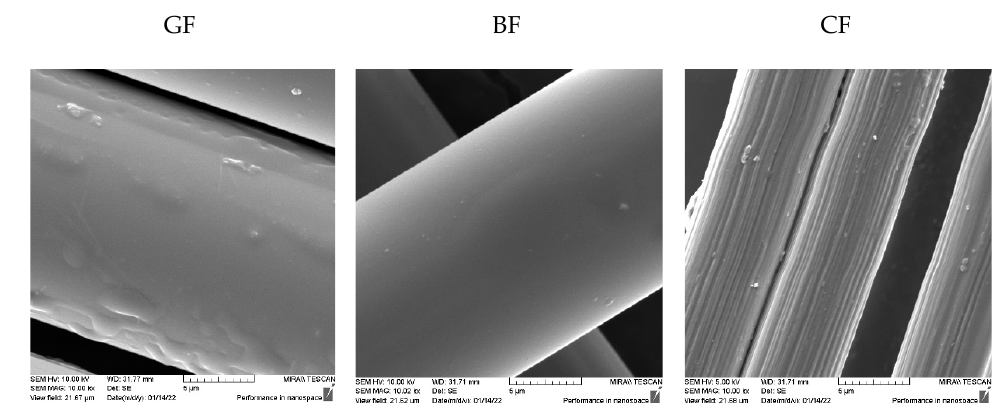
Figure 8. Surface properties of glass, basalt and carbon fibres photographed with a scanning electron microscope (10,000×).